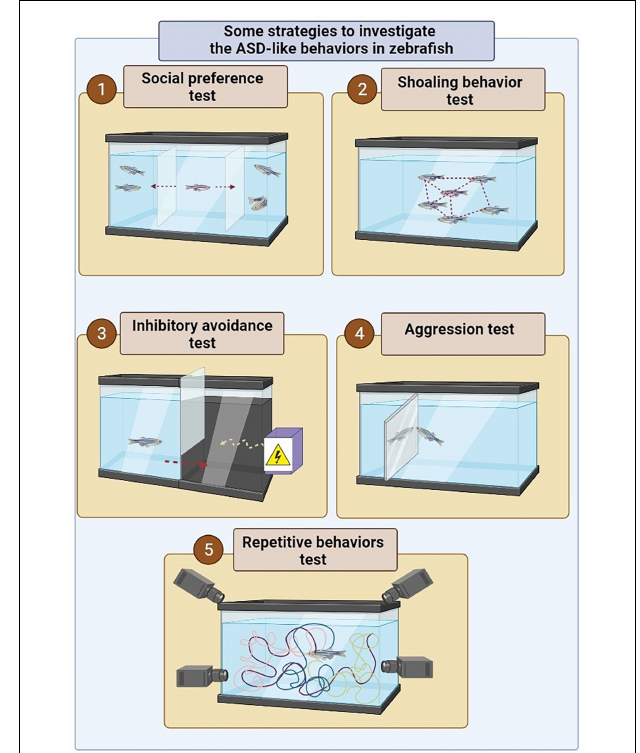
FIGURE 2 | Some strategies to investigate the ASD-like behaviors in zebrafish. (1) In order to assess social preferences, a live zebrafish or robot or photo or zebrafish video is used in an adjacent tank or multi-chamber tank to show the conspecific fish. In this experiment, the social preference behavior is examined by measuring the distance of the fish from the conspecific fish (photo, video, or robot) in the adjacent tank. (2) In order to investigate shoal behavior in the zebrafish, the studied model is placed among a group of conspecific fish inside a tank. In this experiment, the incidence of shoal behavior is determined based on the average distance between the fish in a tank. (3) In order to investigate behavioral avoidance, one of the chamber of the tank becomes dark, which is instinctively more desirable for zebrafish than a brighter environment. However, the presence of the electric shock in a dark environment is considered a risk factor for zebrafish. Hence the conflict between swimming into the dark environment instinctively and avoiding electric shock can be used to investigate behavioral avoidance. (4) In order to assess the aggression behavior, a mirror is applied inside the tank of the zebrafish. (5) The locomotor behavior can be assessed by tracking the position of zebrafish in 3D space and swim path characteristics